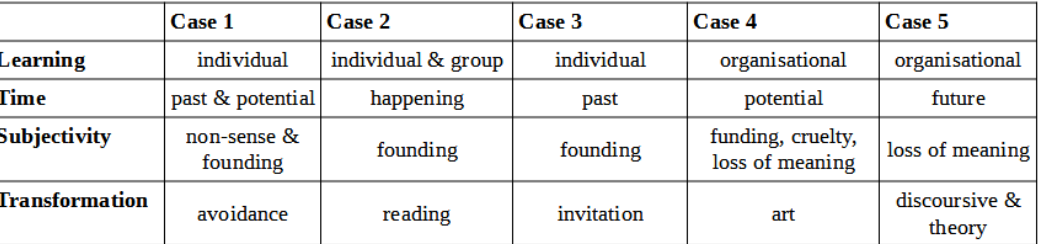
Table 1 . A brief summary of